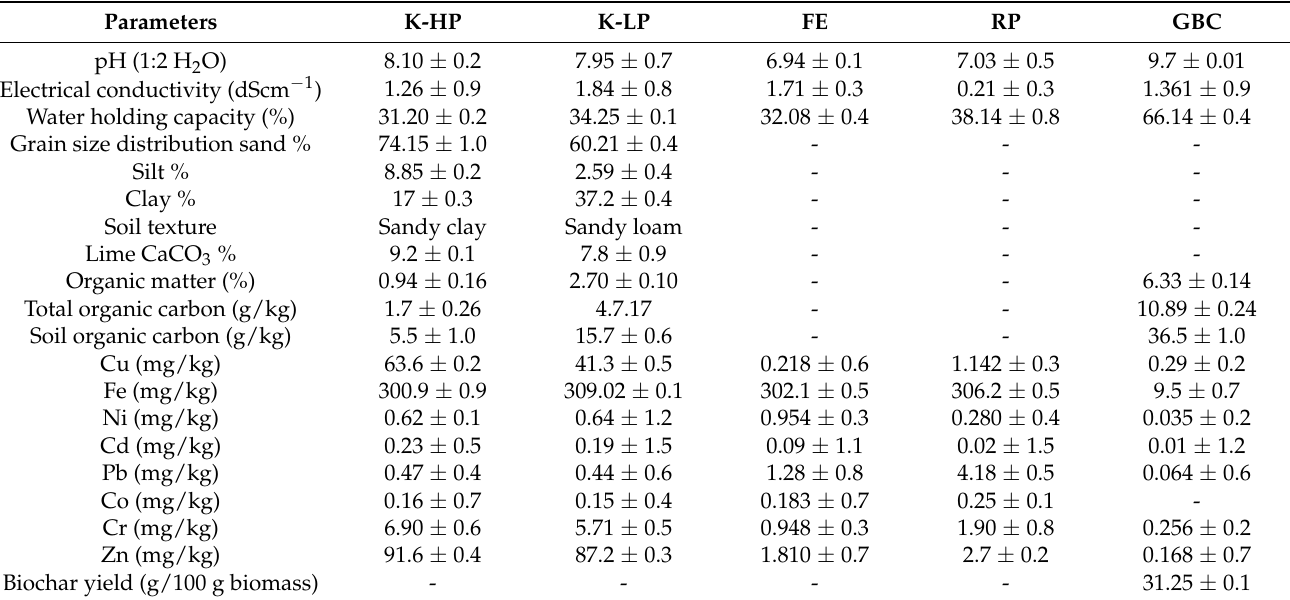
Table 1. Impacts of amendment on the physio-chemical characteristics of